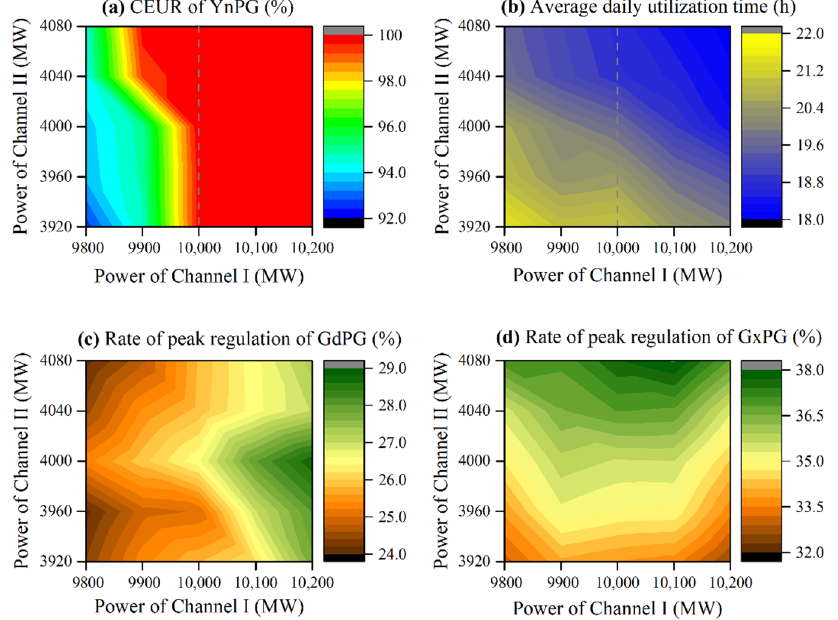
Figure 9. Optimal results including ( a ) clean energy consumption ratio (CEUR) of YnPG, ( b ) average daily utilization time of Channels I and II, and ( c , d ) peak regulation ratios of power generation of GdPG and GxPG received from YnPG with changing Channels I and II.